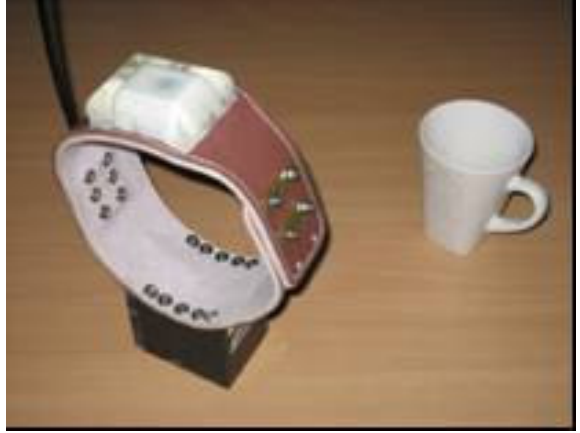
Figure 2. An example of a GPS collar for tracking animal movements (the AgTrax II unit was supplied by Alana Ecology, United